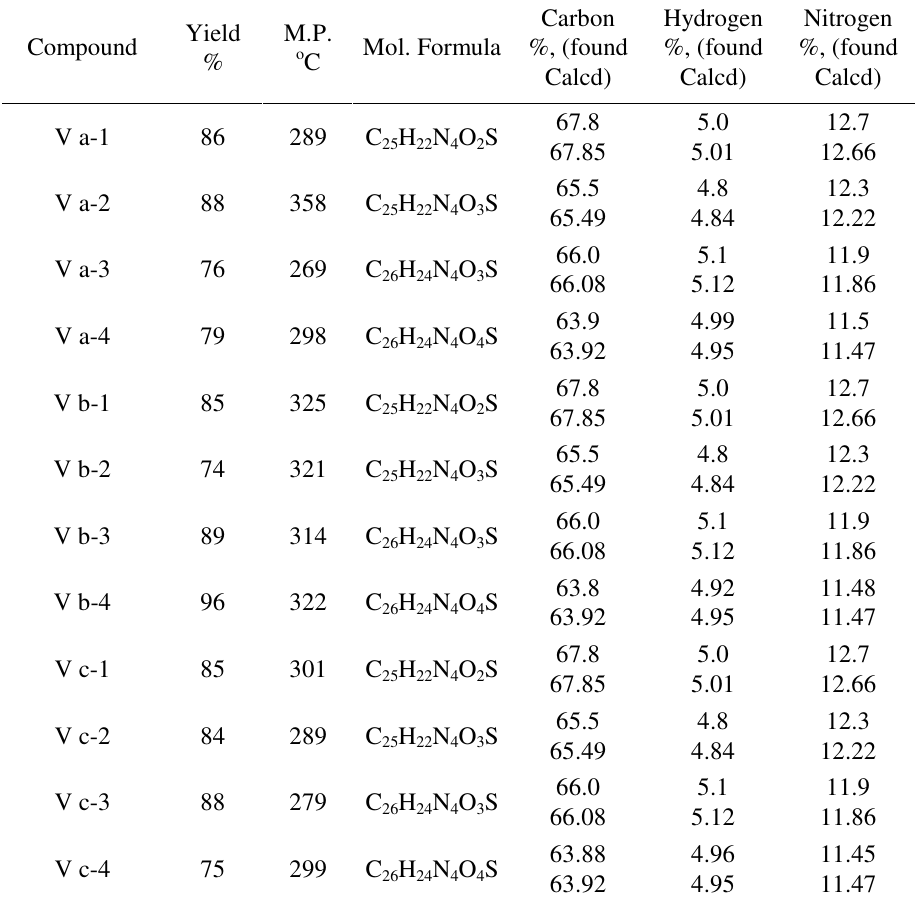
Table 7. General characteristics and elemental analysis data of the compounds V (a-c)(1-4)